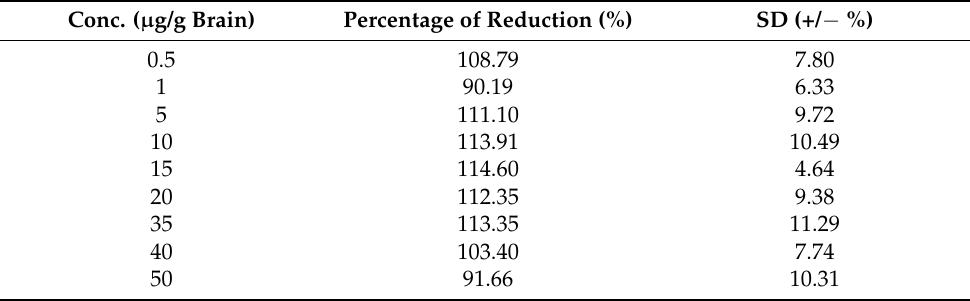
Table 6. Determination of the degree of reduction of oxidized